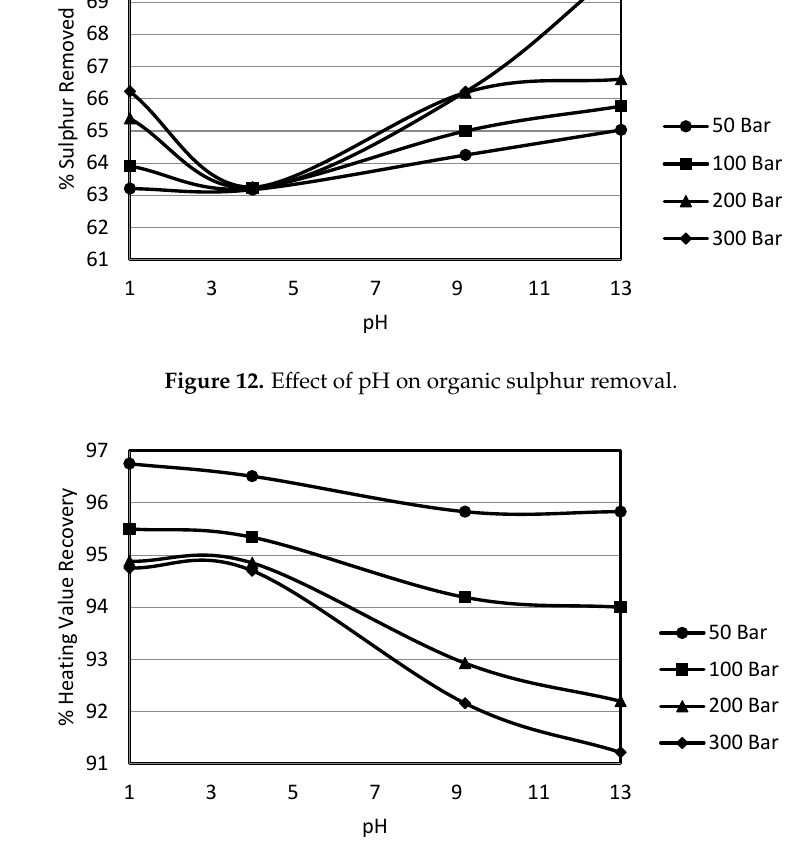
Figure 13. Effect of pH on heating value recovery.